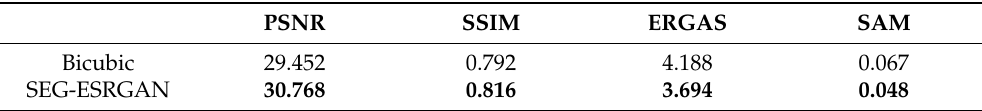
Table 4. Super-resolution metrics for the best model compared with the bicubic interpolation image. Best values in